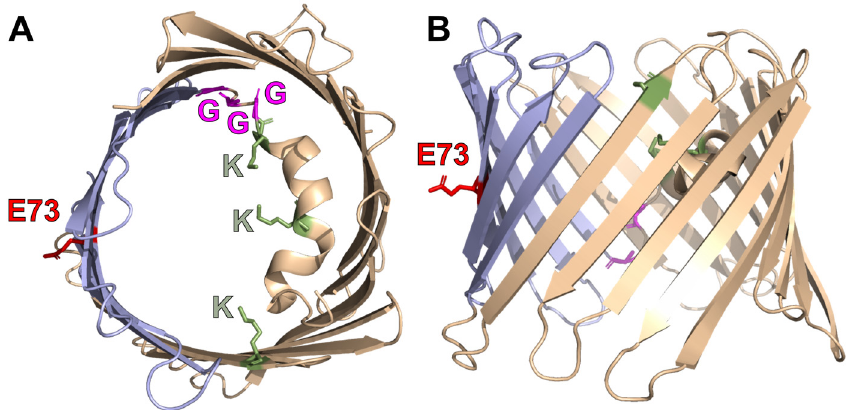
Figure 1. Structure of VDAC and localization of glutamate 73. Top ( A ) and side view ( B ) of the voltage dependent anion channel (VDAC1, pdb: 3 emn) as cartoon representation. Glutamate 73 is shown in red. A six beta sheet region around E73 (purple) was suggested to show higher protein dynamics compared to the rest of the barrel and to interact with the opposite helix to control ion permeation. A glycine stretch previously suggested to mediate protein interaction is shown in magenta and lysines coordinating ATP permeation are shown in green.